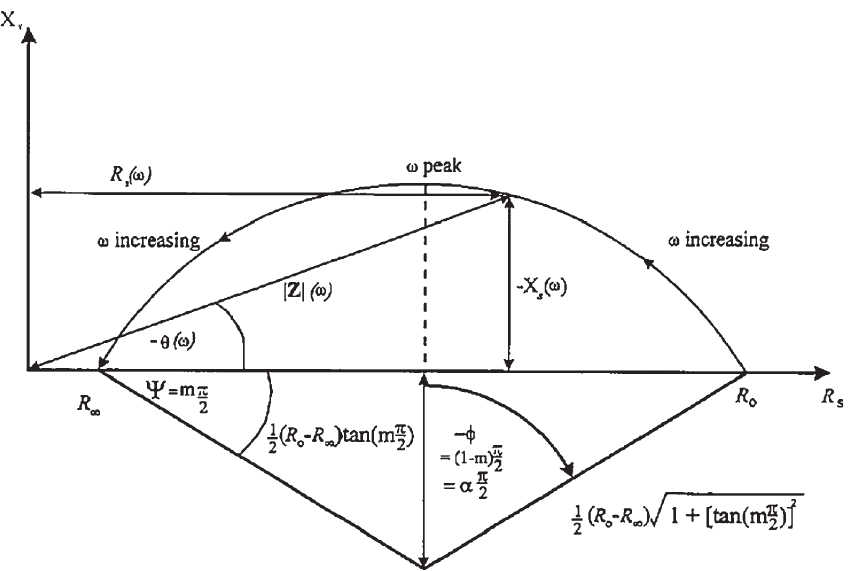
Fig. 2. A diagram of a complex impedance locus for a typical biological tissue. Reproduced from [27].